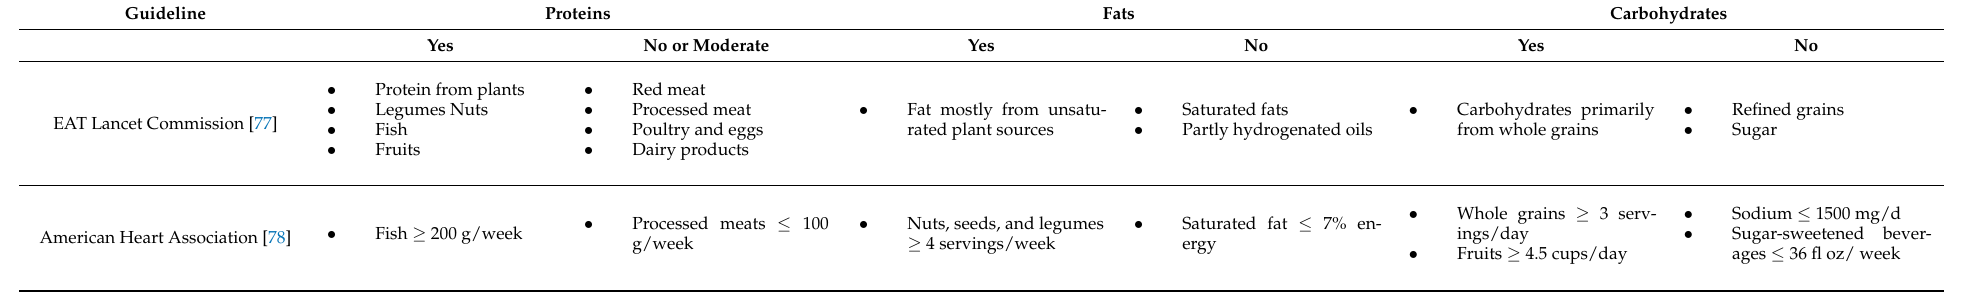
Table 2. Healthy diet